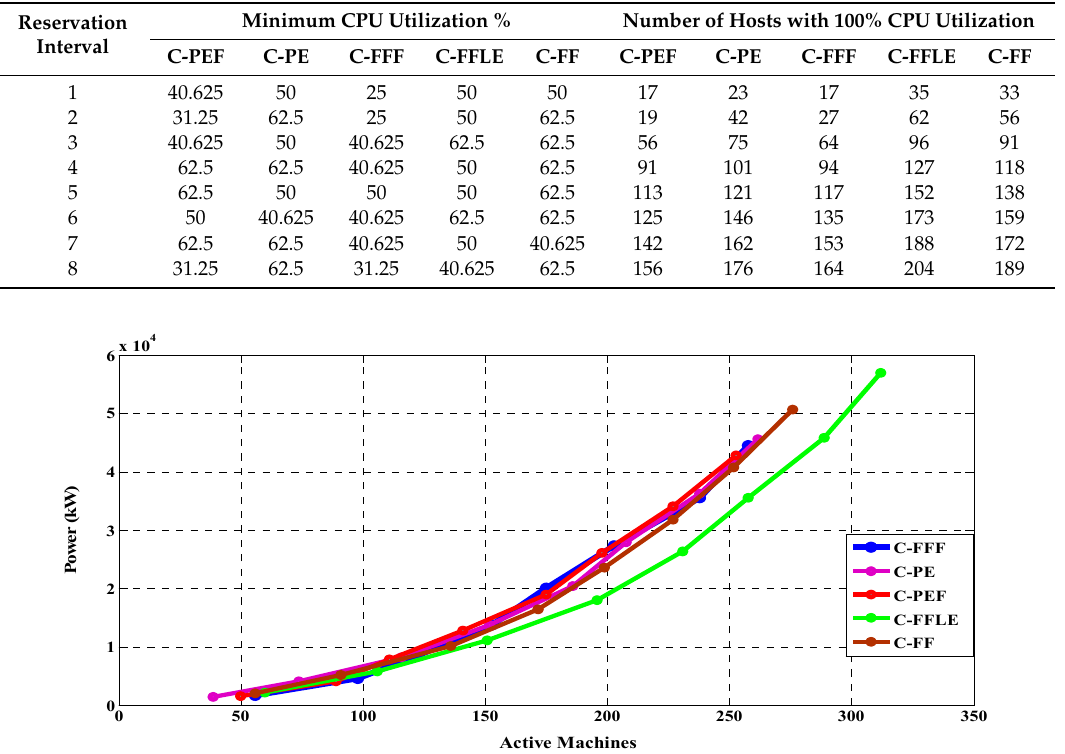
Figure 5. Active PMs with 100% RVA (first 8 reservation cycles).